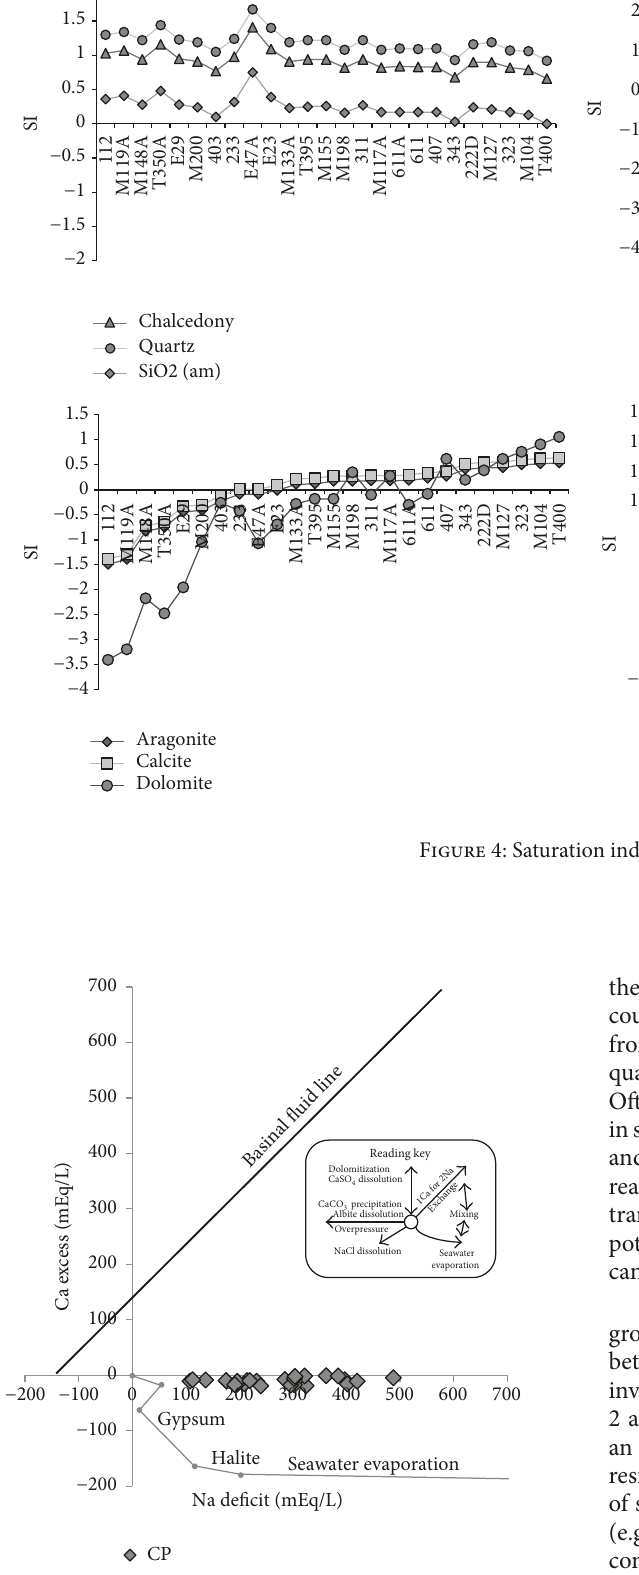
Figure 5: Diagram Na ( deficit ) and Ca ( excess ) . Diamonds correspond to the CP sampled